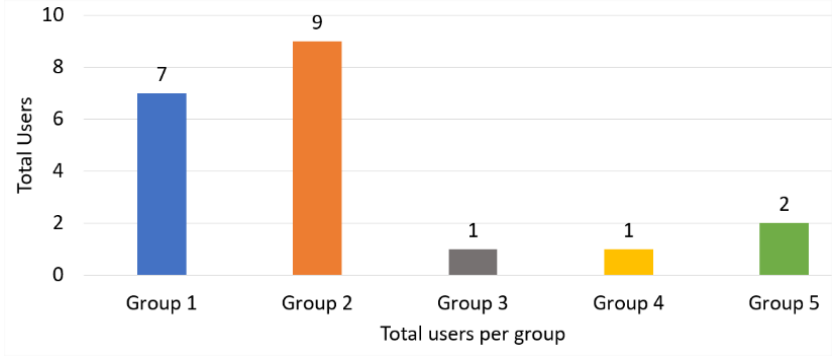
Figure 13. Cataloging collisions of reference group users.